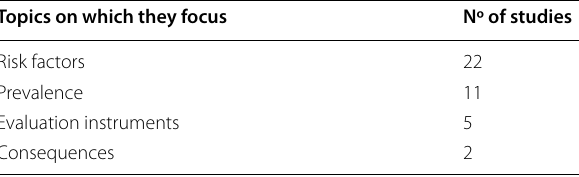
Table 3 Topics covered in the selected articles on prenatal suicidal